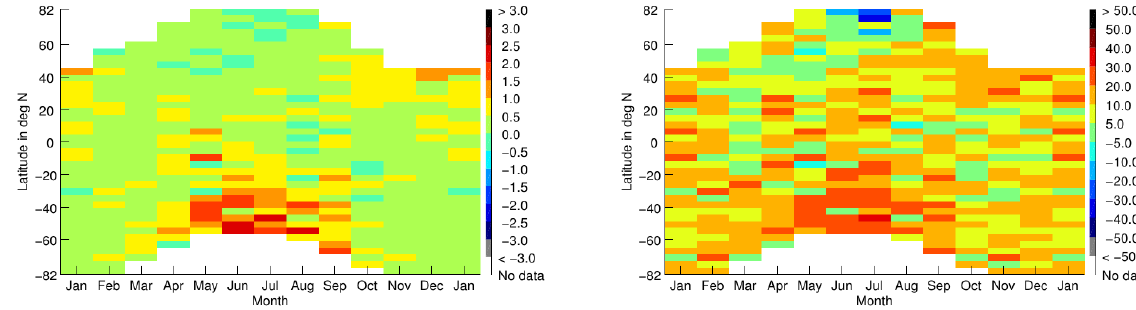
Figure 20. Absolute (left, D 1 − D 2 ) and relative (right, 2 D 1 − D 2